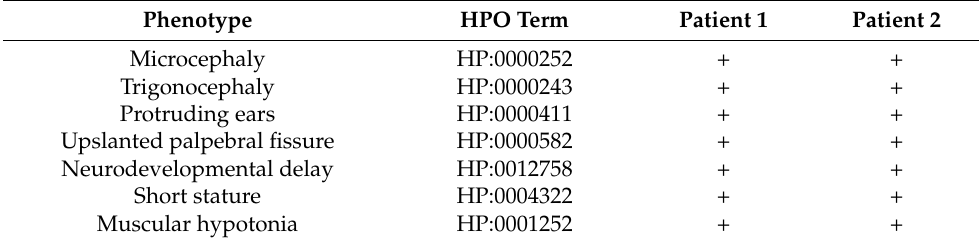
Figure 2. Pictures of patient 1. ( A – D ) Face, hand, and foot at age 9. Notice the asymmetry of the face, complete cutaneous syndactyly of the right second and third fingers, and overlapping toes. Thickened subcutaneous soft tissue on the proximal phalanges (prominently second finger) of the left hand (discoloration on the left hand due to traditional ‘red henna’). ( E ) Radial head dislocation. ( F ) Right hand radiograph showing distal phalangeal bone fusion of the third and fourth fingers at the age of 6. ( G ) Patient 1 at 9 years of age. Notice the generalized hypotonia. ( H ) Patient 1 at 6 years of age. Hyperemic, crusted skin lesions and focal dermal hypoplasia in her neck and axillary region and hypodontia are noticeable. Table 1. Summary of the clinical features observed in each patient.